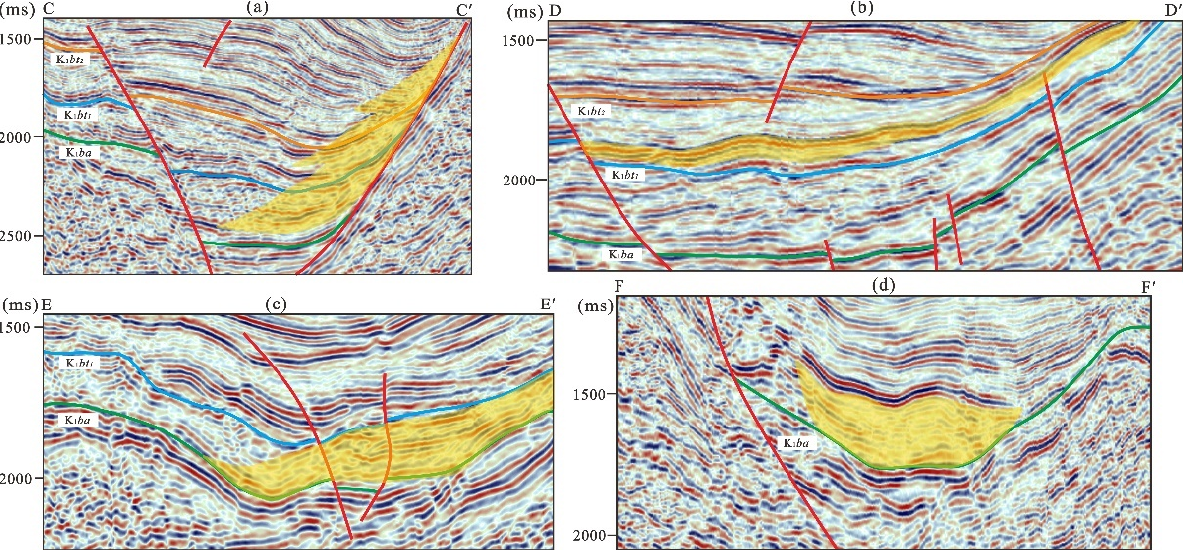
Figure 7. Seismic facies recognized in the Lower Cretaceous secession of the Saihantala sag. ( a ) Wedge-type and chaotic progradational seismic facies. ( b ) S-type progradational seismic facies. ( c ) Downlap-type progradational seismic facies. ( d ) Filled seismic facies. See Figure 1c for the location of these profiles. (The red line represents the faults. The green, blue and orange lines represent the tops of strata K 1 ba, K 1 bt 1 and K 1 bt 2. )